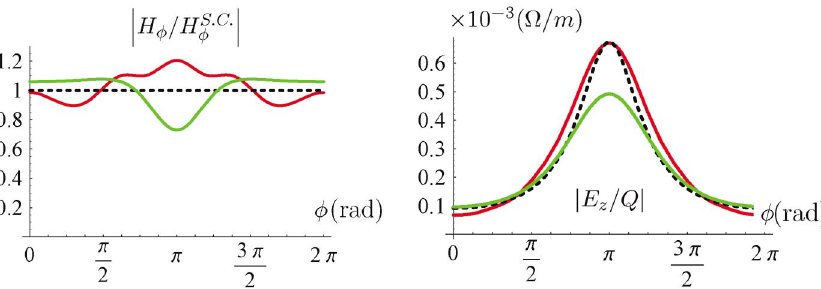
FIG. 7. (Color) Azimuthal magnetic field and longitudinal electric field on the boundary at 1 kHz. The dashed black line is the result of the perturbative approach. The red line is an analytical solution including only the first three (cid:19) -harmonics for (cid:1) 0 : 999 999 and the green one is the complete solution. ( b (cid:1) 2 cm , n (cid:1) 1 )